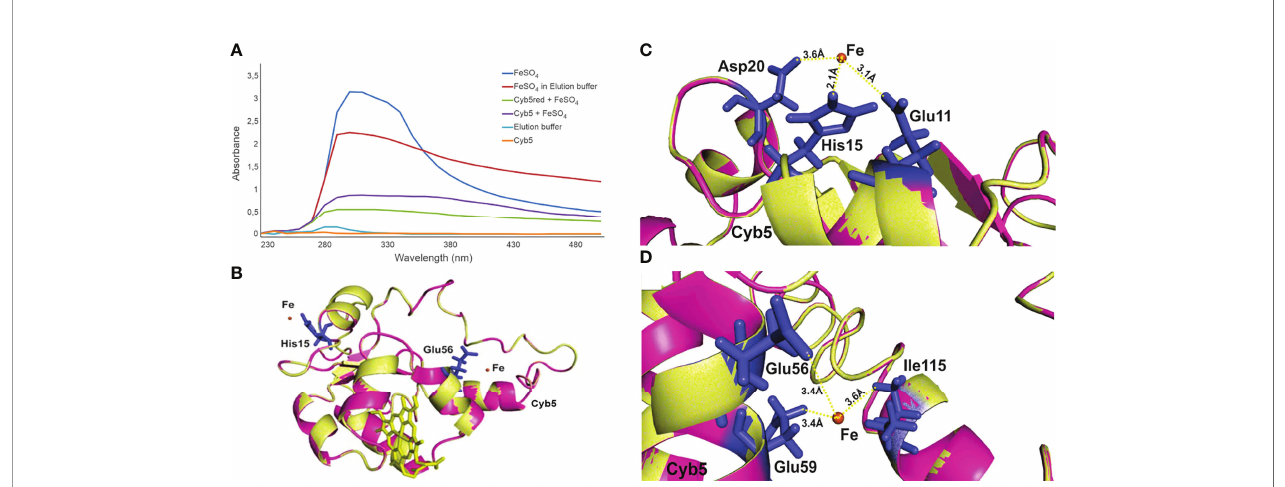
FIGURE 4 | Cyb5 of Paracoccidioides brasiliensis is an Fe-binding protein. (A) Absorbance spectra of the puri fi ed recombinant Cyb5 protein in a lower oxidation state (green — sample previously treated with a reducing agent) and higher oxidation (purple). Controls: ferrous sulfate solution (dark blue), ferrous sulfate prepared in elution buffer (red), elution buffer (light blue), and puri fi ed recombinant Cb5 (orange). (B) The structural alignment of Cyb5 with iron-binding motifs resulted in two sites of iron binding for this protein with signi fi cant scores. Residues interacting with the iron ion are shown as sticks and labeled as His for histidine and Glu for glutamate. These are the amino acid residues less distant from the iron centers. Iron is shown as a brown sphere. (C) The structural alignment showed that His15 binds to iron in the distance of 2.1 Å, reaching a score above the threshold. The same residue may interact with iron more than once. Glutamic acid 11 (Glu11) and aspartic acid 20 (Asp20) bind to iron in the distance of 3.1 and 3.6 Å, respectively. (D) The structural alignment showed that the residues Glu56 and Glu59 bind to iron within the distance of 3.4 (A) Isoleucine 115 (Ile115) binds to iron with a lower score but still above the threshold. Bonds to the iron are shown as dotted yellow lines, with bond distances indicated next to the